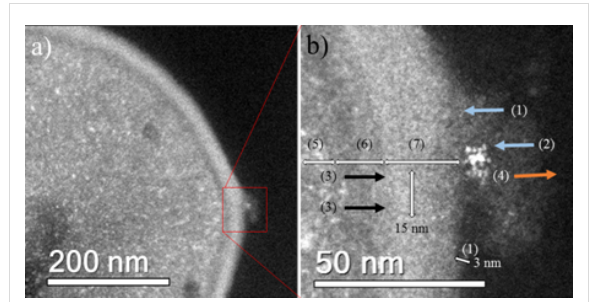
Figure 3: (a) HAADF-STEM image of an untreated MRSA cell. (b) High magnification image of a MRSA cell wall containing peptido- glycan layers with a total thickness of 40 nm. (c) An undamaged MSSA cell wall. (d) A high magnification image of a MSSA cell wall showing the cell envelope layers.